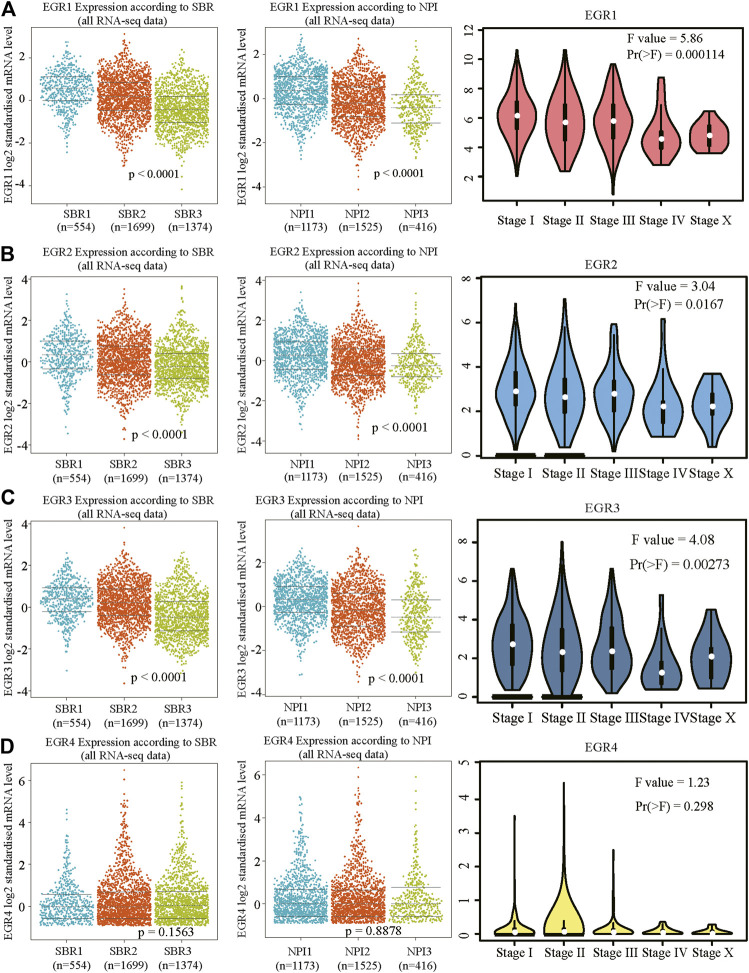
Relationship between mRNA levels of EGRs and SBR, NPI, or stage in BRCA. Beeswarm plots of EGRs expressions according to SBR, NPI, and stage. (A) EGR1, (B) EGR2, (C) EGR3, and (D) EGR4.